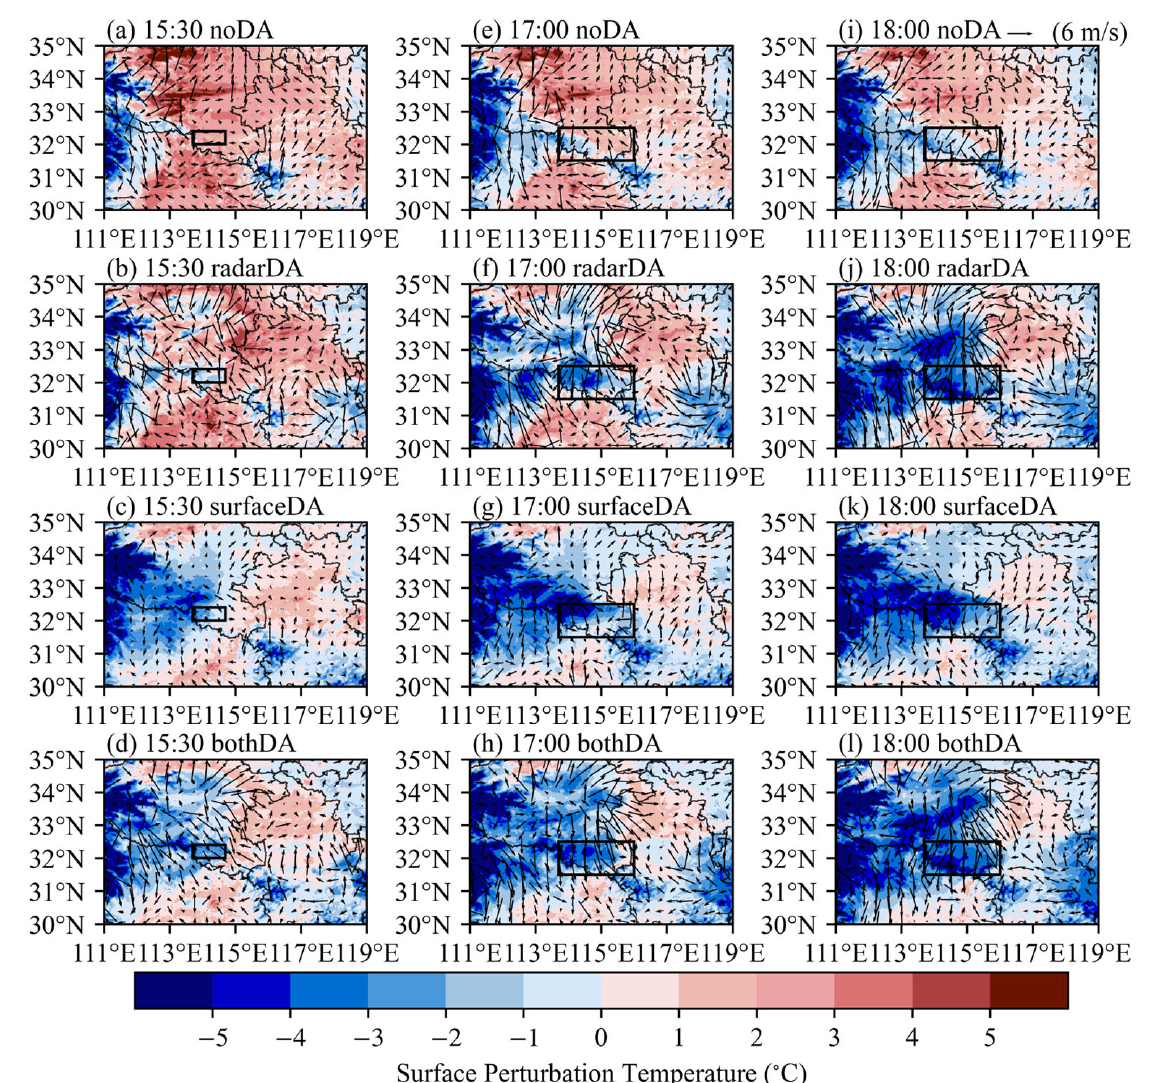
Figure 16. The horizontal distribution of wind field at 10 m (quiver, unit: m/s), and surface perturbation temperature (shaded, unit: °C ) at 1530, 1700 and 1800 UTC 11 July 2014 for ( a ) noDA, ( b ) radarDA, ( c ) surfaceDA and ( d ) bothDA experiments. The black boxes in ( a – d ) represent the location of initiation of the squall line (same as in Figure 9), and the black boxes in ( c – l ) represent the location of the main body during the mature of the squall